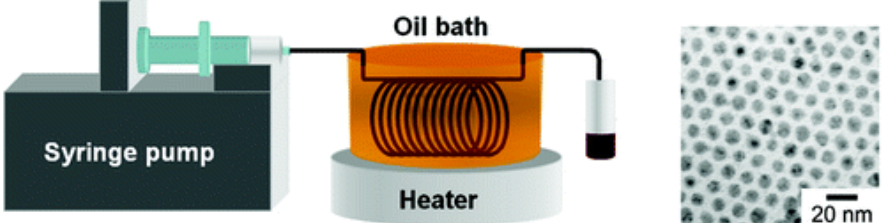
Figure 13. Synthesis of silver nanoparticles in a tubular microreactor